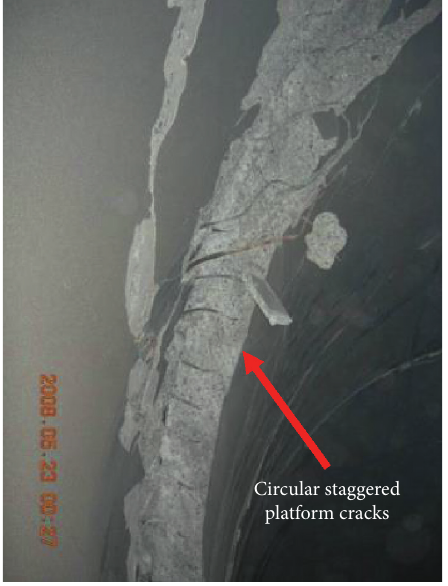
Figure 10: Circular staggered platform cracks after